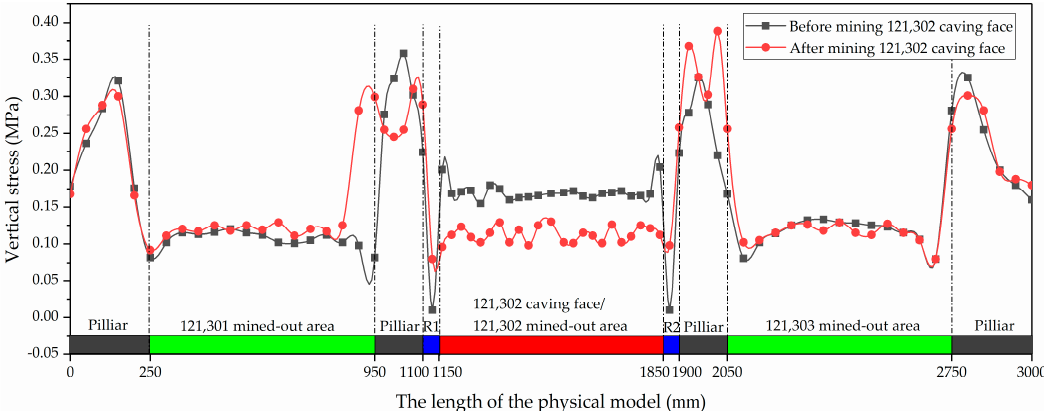
Figure 5. Vertical stress curve of measuring line A before and after mining of the 121,302